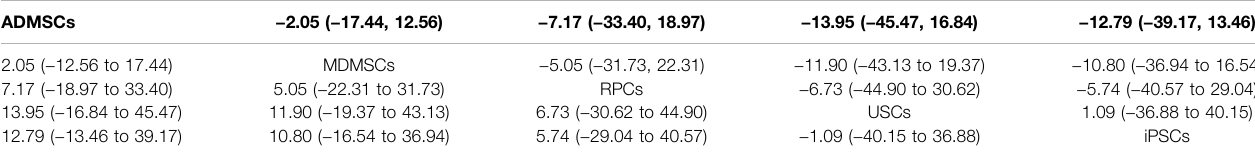
TABLE 16 | Network Meta-analysis results of proliferation of resident cells in stem cell groups in early stage after administration.